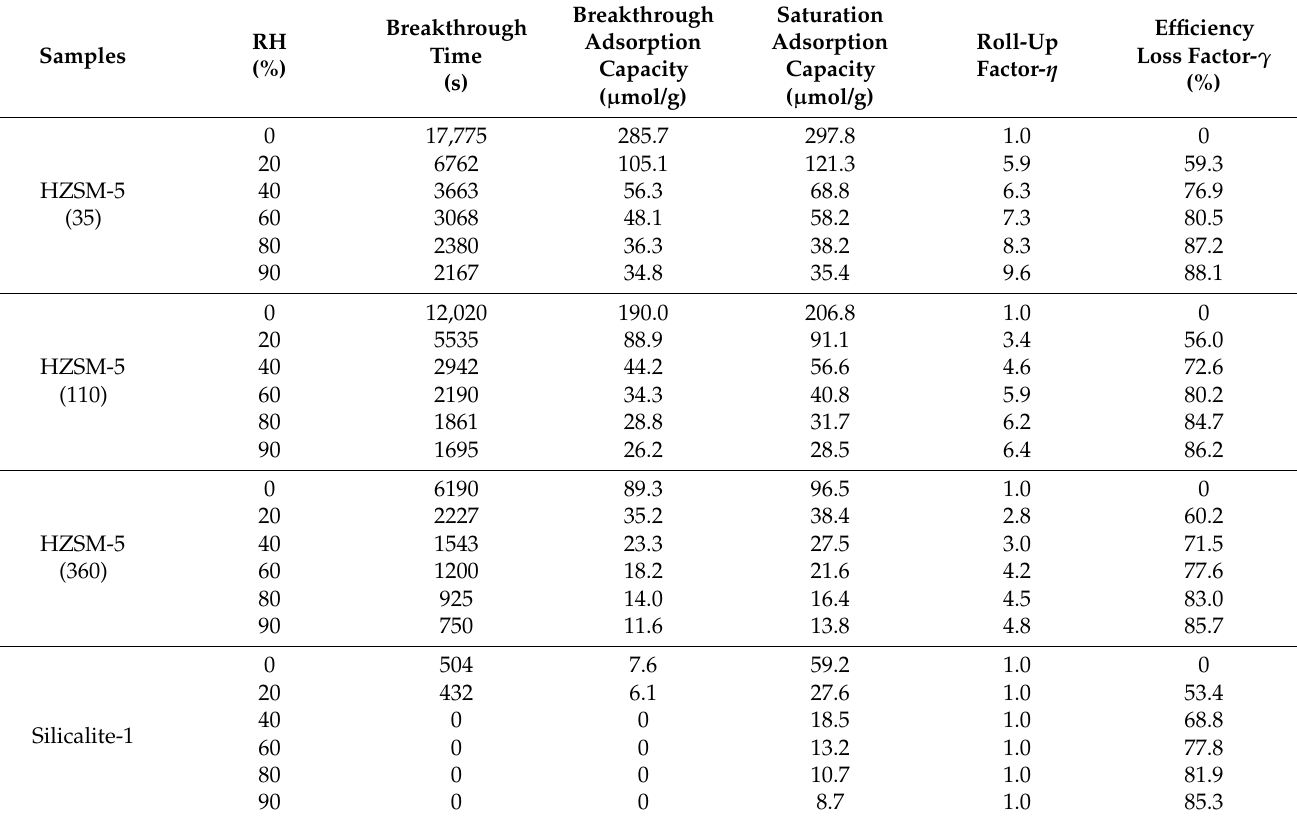
Table 2. Summary of the dynamic adsorption properties, roll-up factor, and efficiency loss factor of NO x on MFI zeolites at 25 ◦ C under different RH